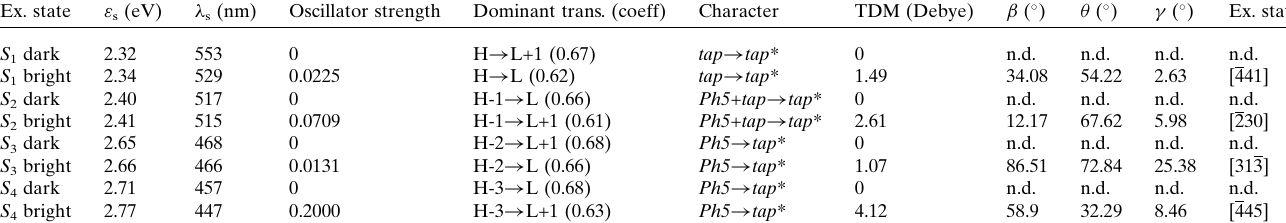
Table 2 Low-lying optical transitions (singlets only) of the TAAP dimer in the gas phase, calculated at the TD-DFT/B3LYP level. The transition wavelengths ( (cid:5) s ) are obtained after shifting the TD-DFT transition energies by (cid:7) 0.33 eV ( " s ). H is the HOMO and L is the LUMO. (cid:6) is the angle between the direction of the permanent dipole moment (PDM) and the transition dipole moment (TDM). (cid:8) is the complementary angle between the TDM and the normal to the plane of the molecule. (cid:9) is the angle between the TDM and the vector connecting the centre of mass of the two molecules in the dimer, n.d. is not defined. Ex. state